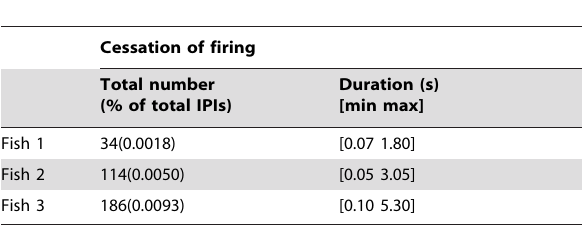
Table 1. Cessation of firing for 48 h non stimulated